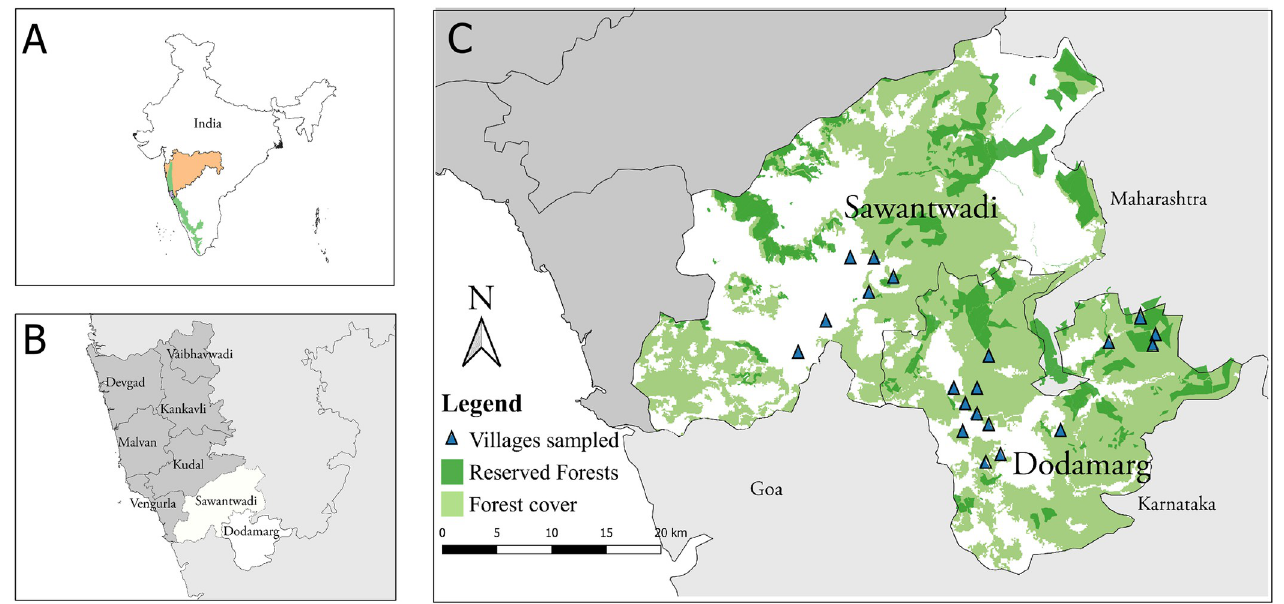
Fig 1. A map depicting (A) the state of Maharashtra (in orange) and the extent of the Western Ghats (in green), (B) all the tehsils within Sindhudurg district with the tehsils of Sawantwadi and Dodamarg in white, and (C) the locations of the villages where interviews were conducted (blue triangles), the extent of forest cover (in light green) and Reserved Forests (dark green) within Sawantwadi and Dodamarg (Data sources: https://bhuvan.nrsc.gov.in/home/index.php; https://gadm.org/data.html; Maharashtra Forest Department;